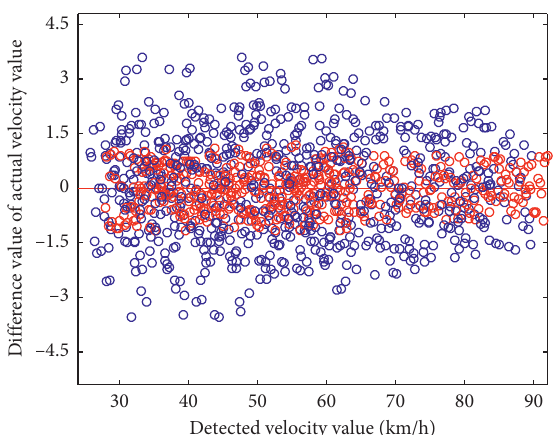
Figure 10: The calibration error